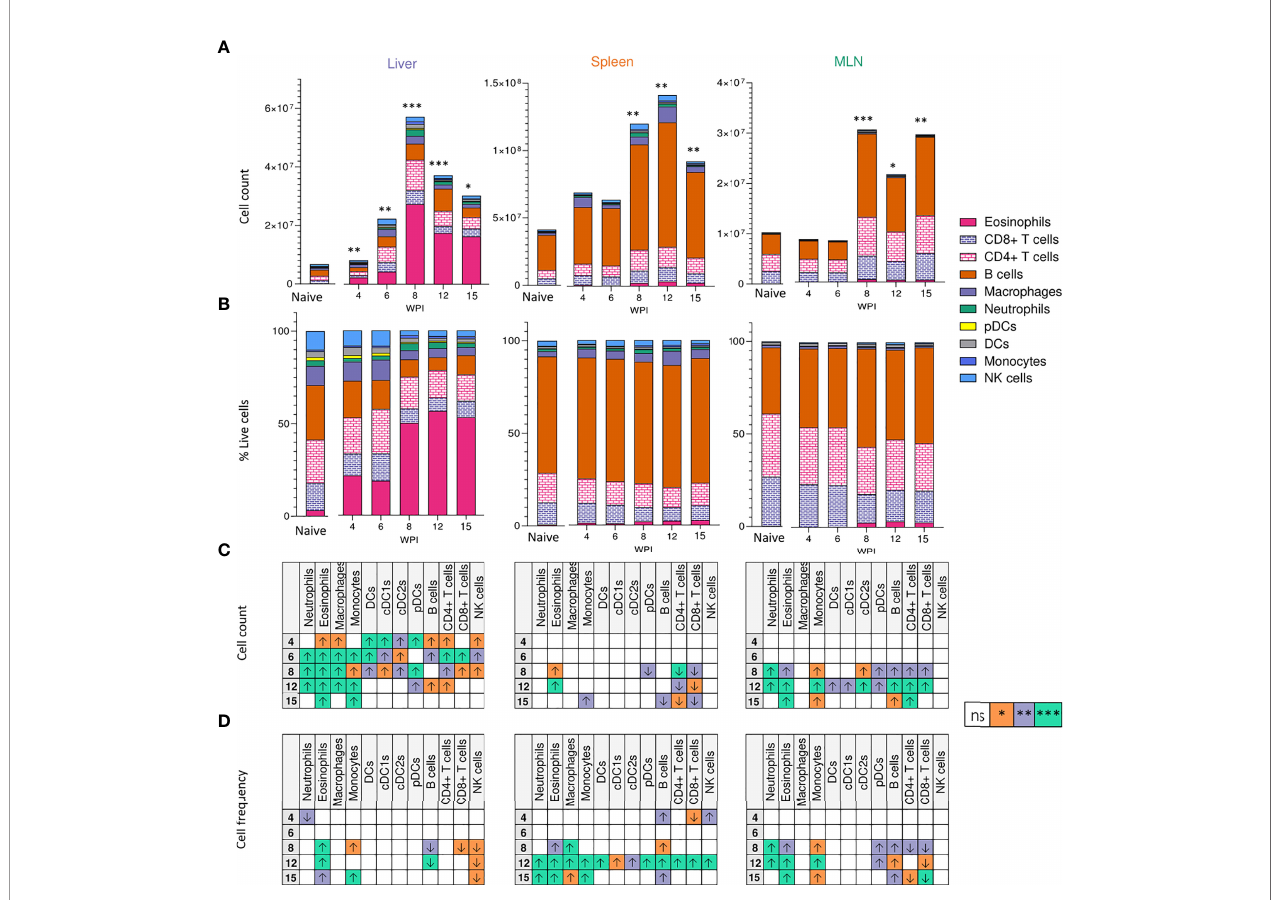
FIGURE 2 | Tissue-speci fi c cellular responses during schistosomiasis. Stacked bar charts showing hepatic splenic and mesenteric (A) cell counts and (B) cell frequencies (as a proportion of total live cells) at indicated wks of infection when infected with 40 cercariae. For infected mice, data is presented as mean values for each given time point, with averages calculated from two pooled experiments per time point. n=6-8 per timepoint from two pooled experiments. Naïve data is presented as mean values for the entire infection, with averages calculated from two pooled time course experiments. n=30. Signi fi cance in (A) re fl ects comparison of total cell counts between naïve and infected mice. Statistics tables showing differences in (C) cell counts and (D) cell frequencies between naïve and infected mice, for the liver spleen and MLN. Arrows in table (C, D) represent the direction of cell frequency change in infected animals in comparison to naïve. Signi fi cance calculated by Kruskal-Wallis followed by Dunn ’ s multiple comparisons test, with comparison between naïve and infected groups. *p < 0.05, **p < 0.01, ***p < 0.001, ns = non-signi fi cant (P > 0.05)